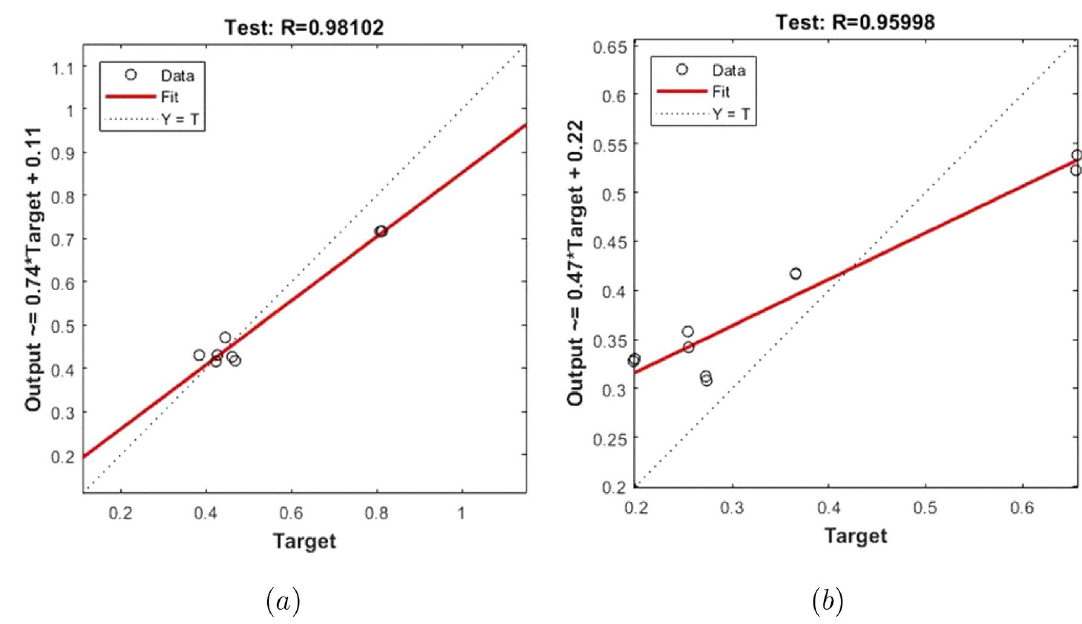
Figure 19. Test data ( a )Skin Friction Coefficients ( b ) Nusselt